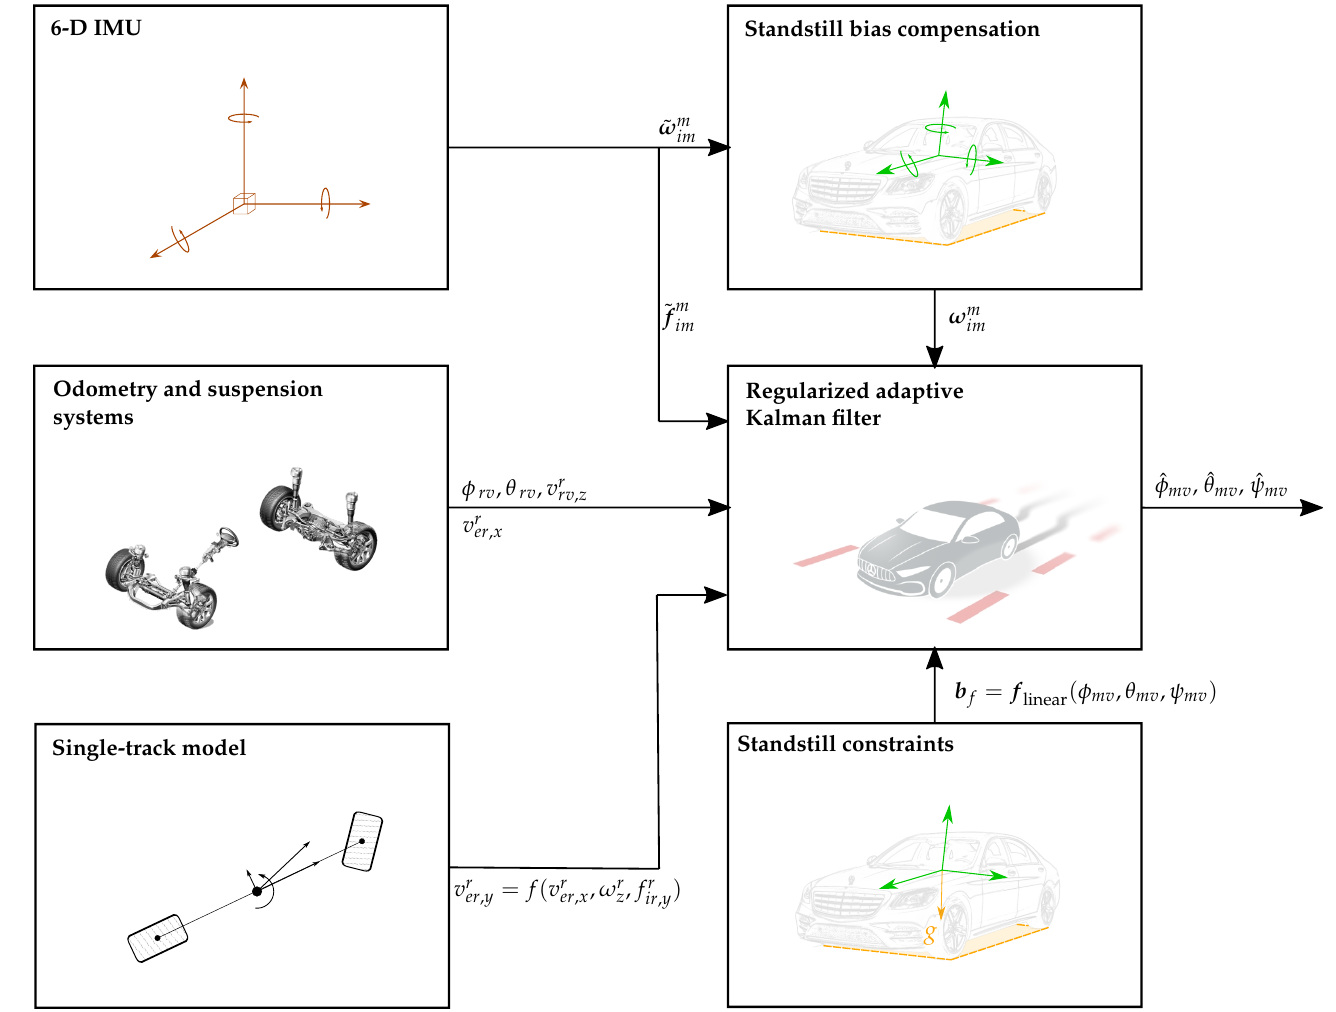
Figure 12. Estimation approach for the IMU–vehicle misalignment estimation. The proposed regularized adaptive Kalman m filter relies on the specific forces (˜ f ) supplied by an automotive-grade 6D IMU, its bias-compensated angular rates ( ω m im well as over-road longitudinal, lateral and vertical velocity information ( v r er , x , v r er , y , v r rv , z ) mainly provided by the odometry, single-track model and suspension, respectively. Furthermore, the vehicle-to-road orientation ( φ rv , θ rv ), computed from the suspension signals, is used to relate the over-road velocities to the vehicle velocity ( v v ev ), see Figure 4. Finally, constraints stemming from a standstill phase are used to enhance the performance of the